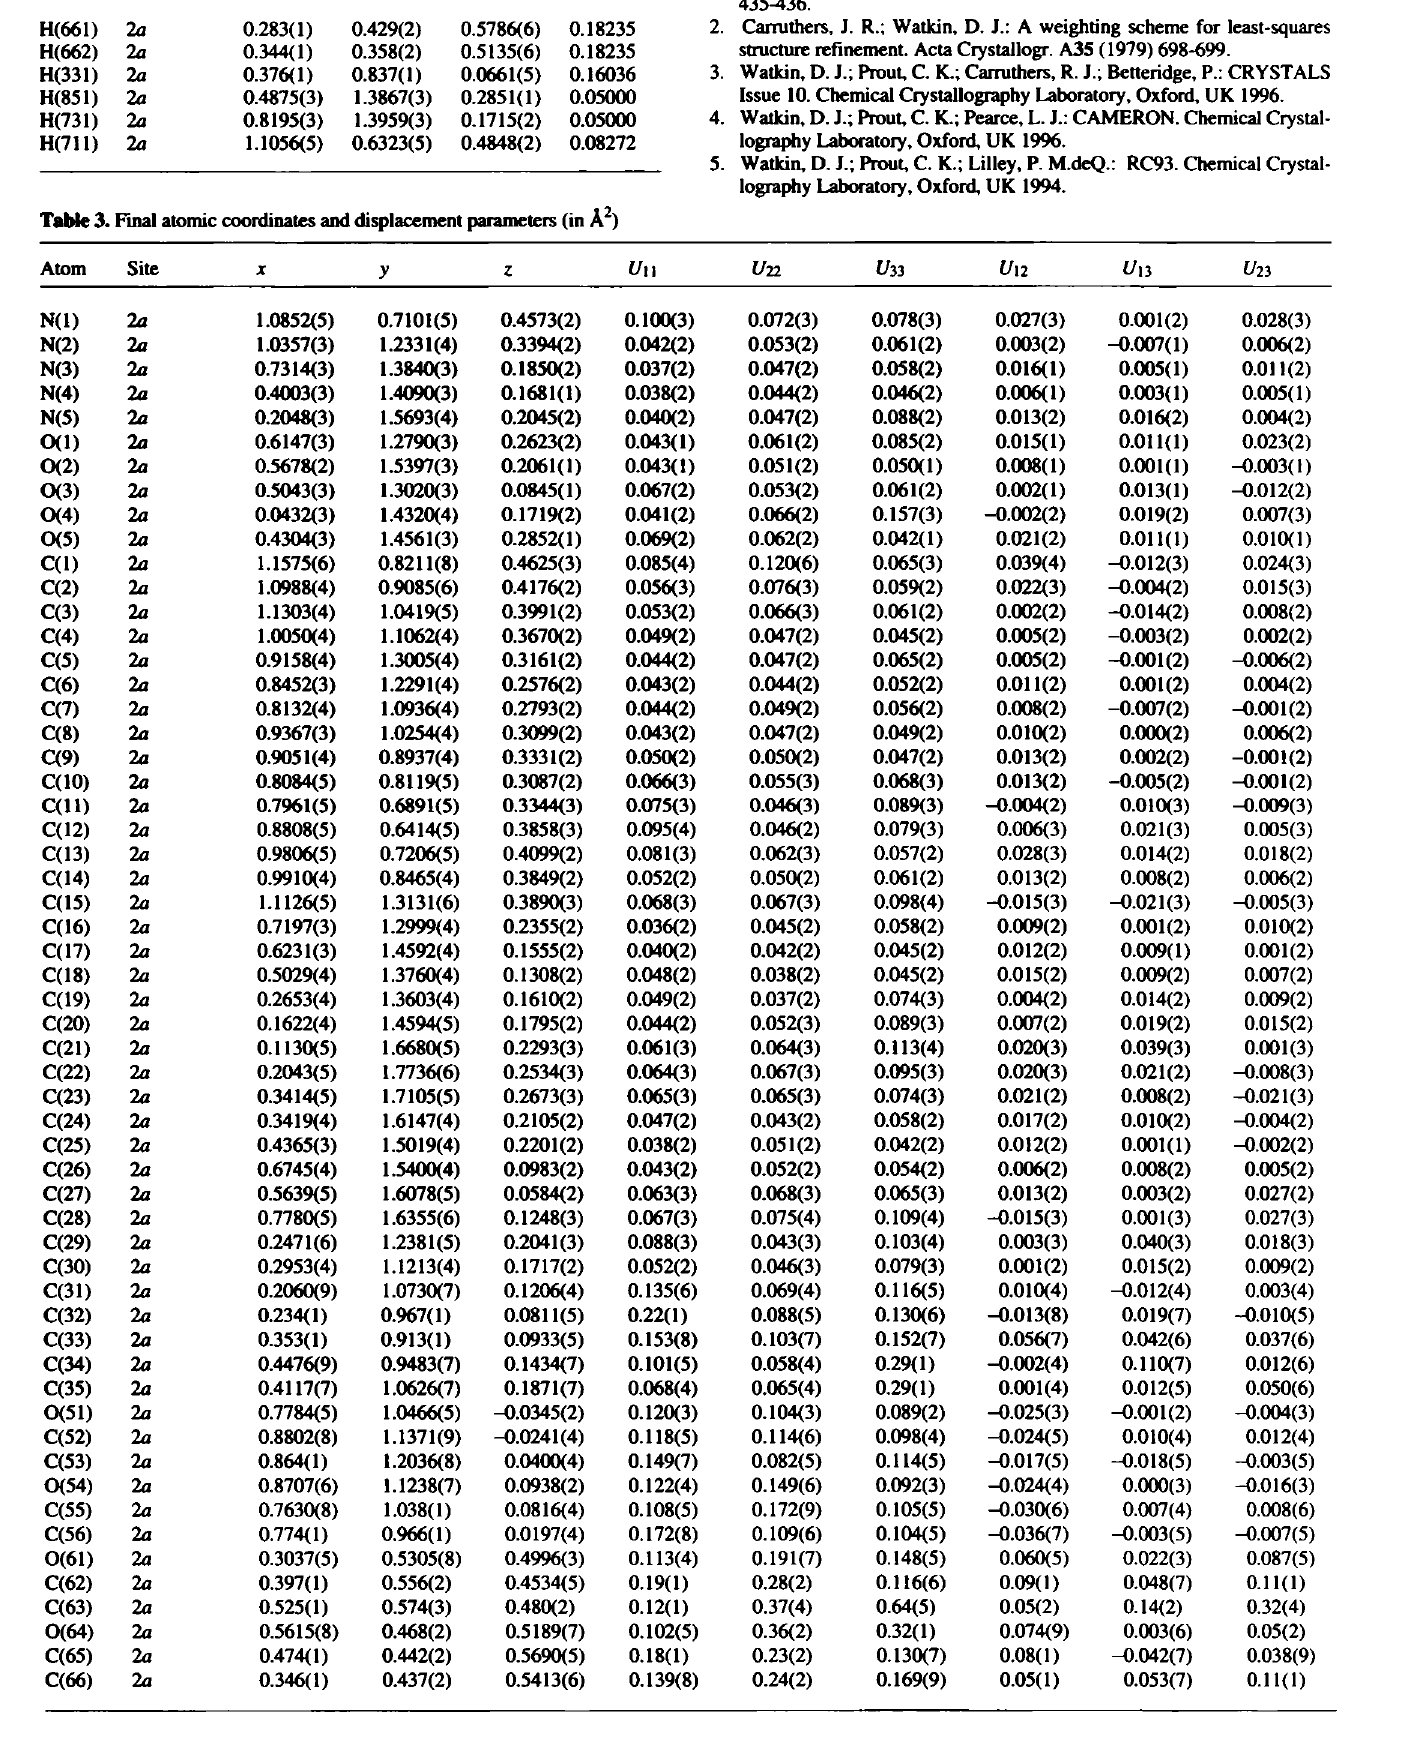
Table 3. Final atomic coordinates and displacement parameters (in A 2